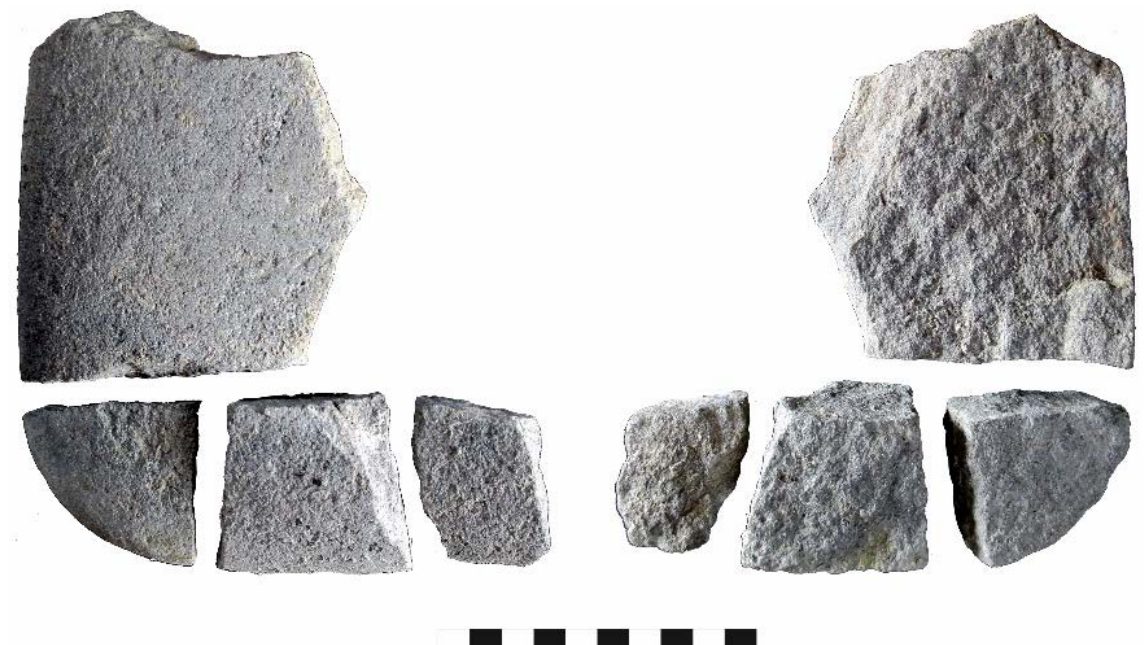
Figure 14. Grinding slab broken through flaking in several pieces from an AVGI I open area. All pieces are refitted (scale in